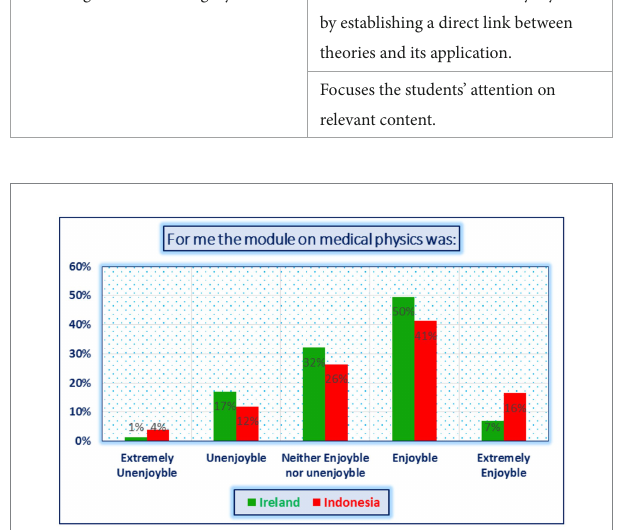
FIGURE 2 Responses of students indicating their level of enjoyment of the